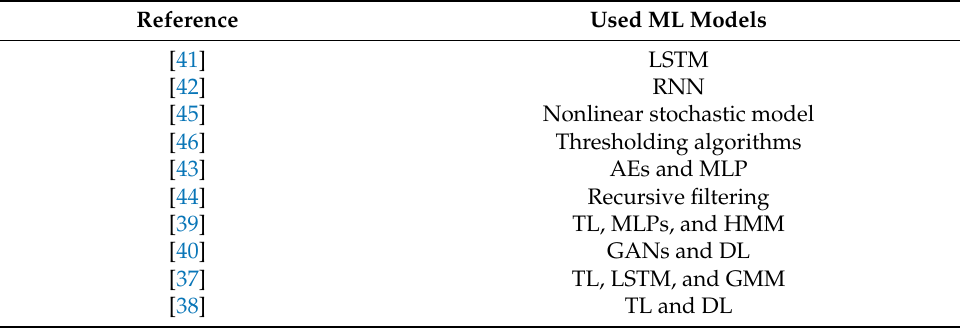
Figure 5. Illustration of the PRONOSTIA platform [25]. Table 3. Learning models used for incomplete unlabeled